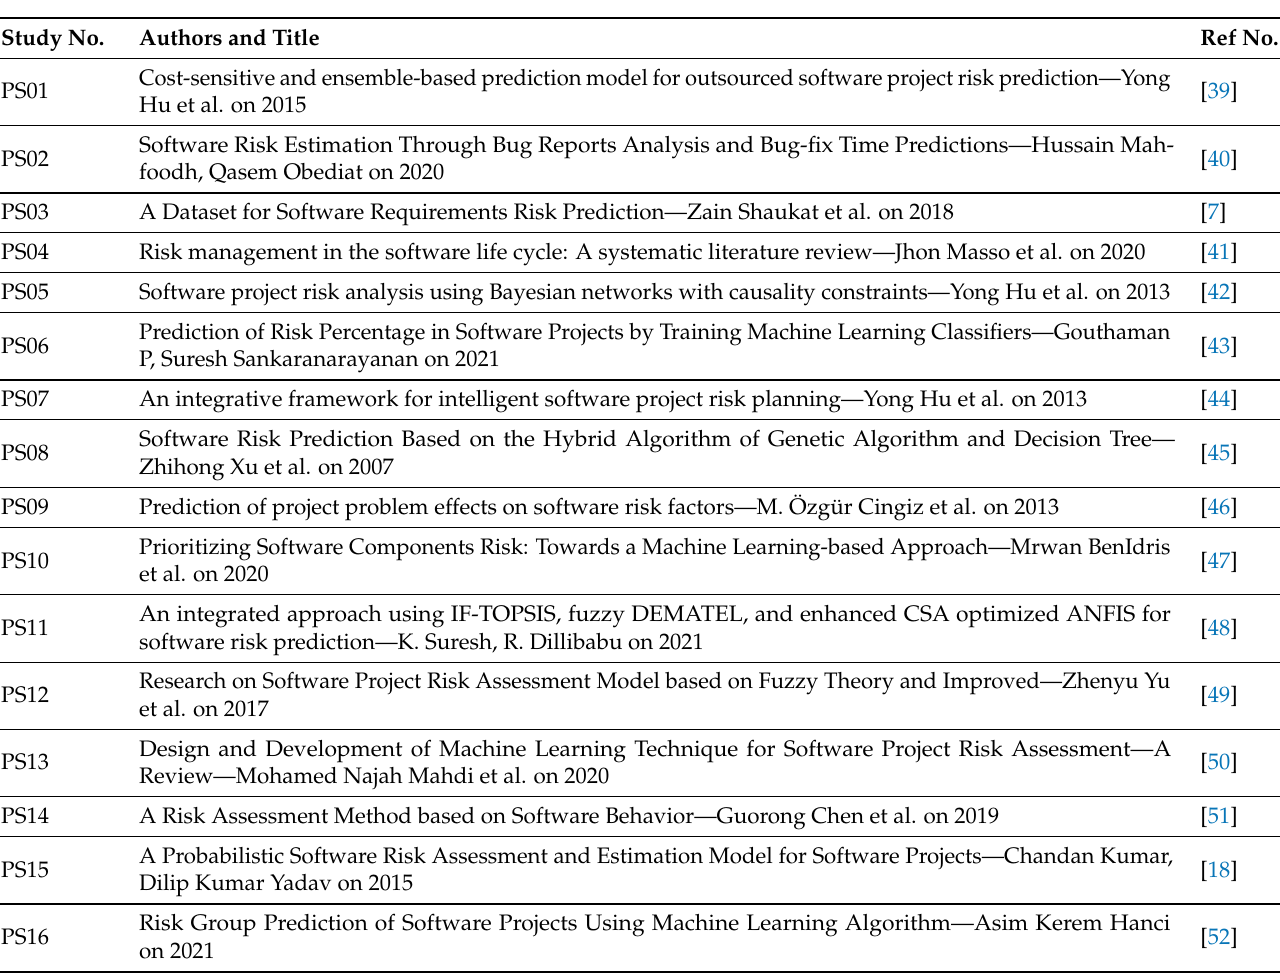
Table 3. Selected PS with